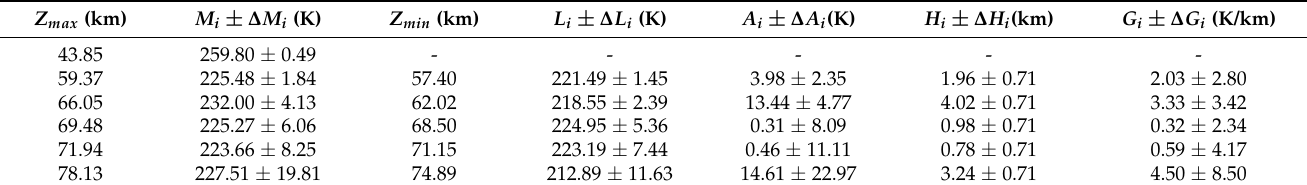
Table 1. Potential MIL anomalies on the vertical temperature profile derived from lidar observation on 4 January